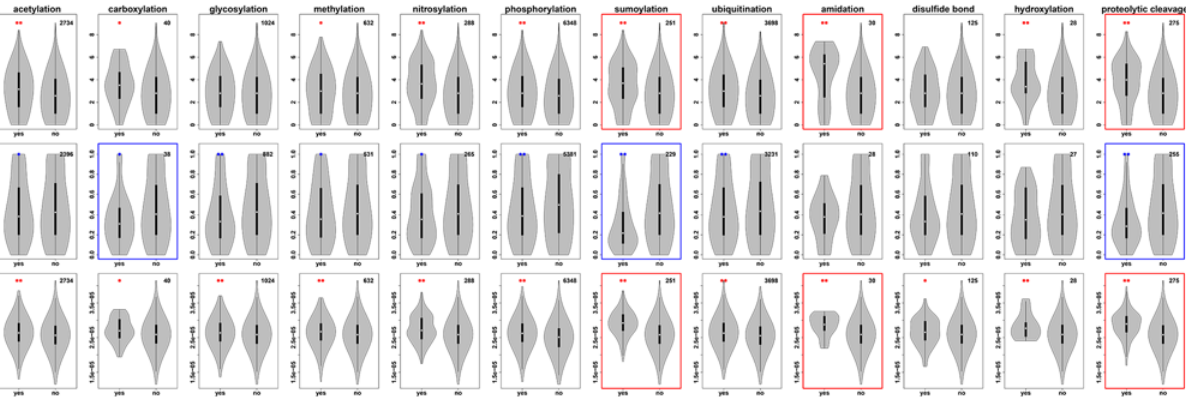
Figure 4. Protein interaction network properties of proteins associated with different PTM-types in Homo sapiens . The network property values of proteins annotated to undergo a particular PTM-type or not are shown by violin plots. The number at the top right corner of each graph represents the number of proteins with the corresponding PTM-type and valid network property definitions in Homo sapiens . Protein interactions were taken from the STRING database. The total numbers of proteins and associated number of interactions in Homo sapiens with confidence score > =0.9 were 8,949 and 71,153, respectively. The red (blue) asterisks at the top of violin plot represents the corresponding PTM group has a significantly higher (lower) median value compared to the non-PTM group ( * : p -value 0.05, ** : p -value 0.01) by Mann-Whitney test with FDR correction. The top 3 PTMs which have high percentage of median difference between PTM group and non-PTM group for each network property are highlighted with red (increased) or blue (decreased) margin.